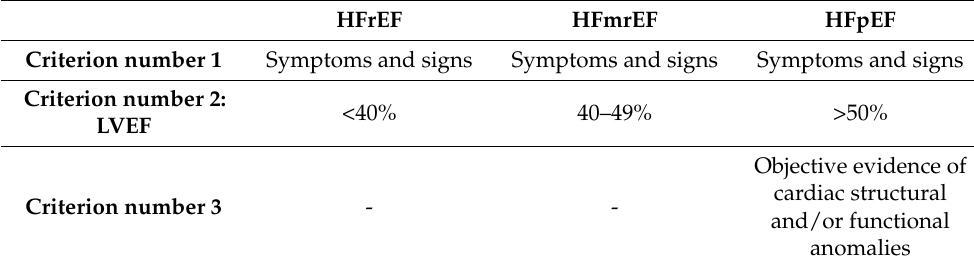
Table 1. Determination of Heart failure (HF) phenotype according to ESC 2021